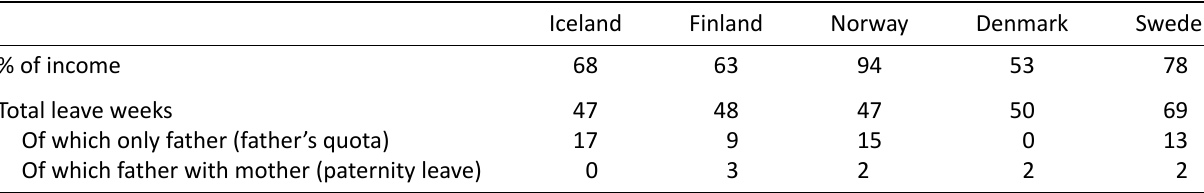
Note: Full-time leave. Source: Based on data from Duvander et al. (2019) and Moss and Duvander (2019). Benefit level data from OECD